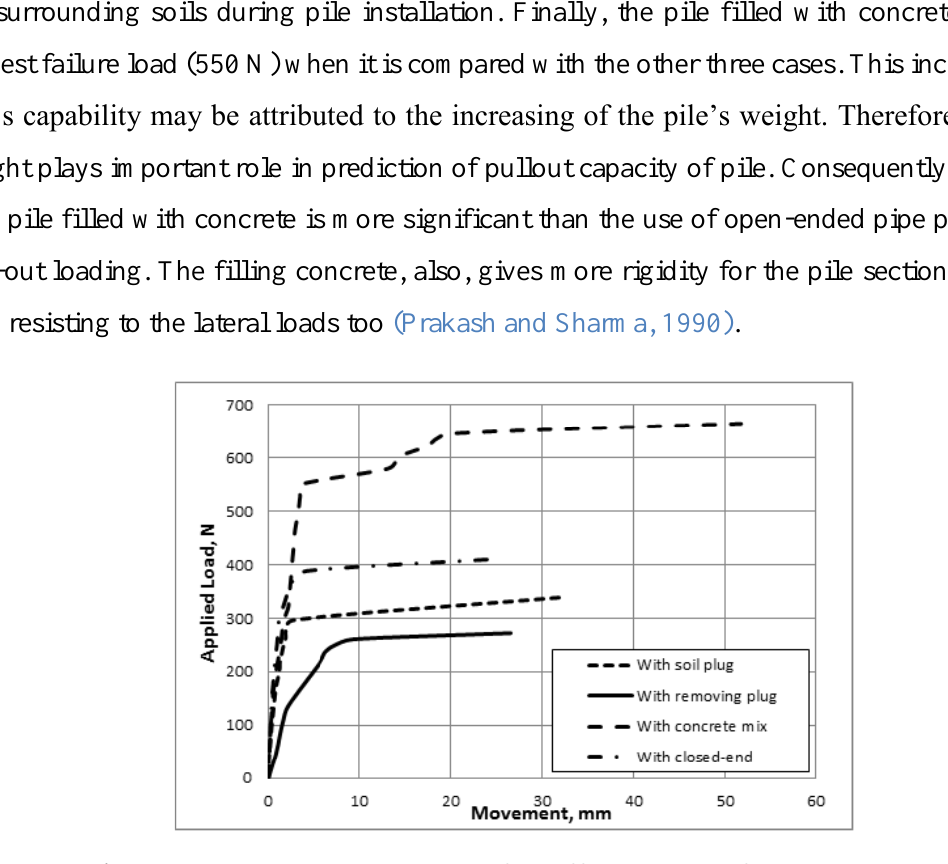
Fig. 6. Loading-movement curves for different cases of plug